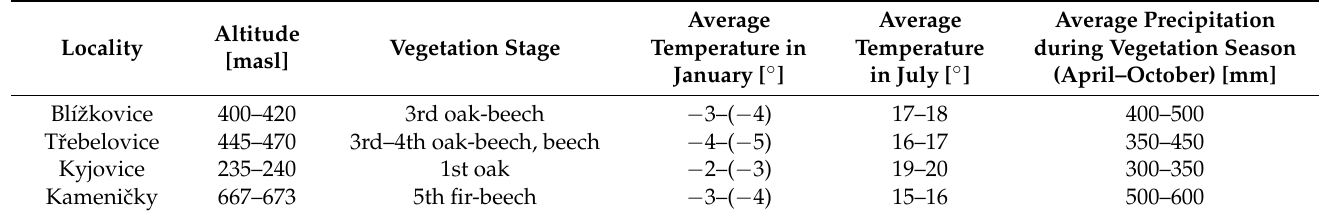
Table 1. Basic habitat ecological characteristics applied within Habitat Valuation Method (HAM)